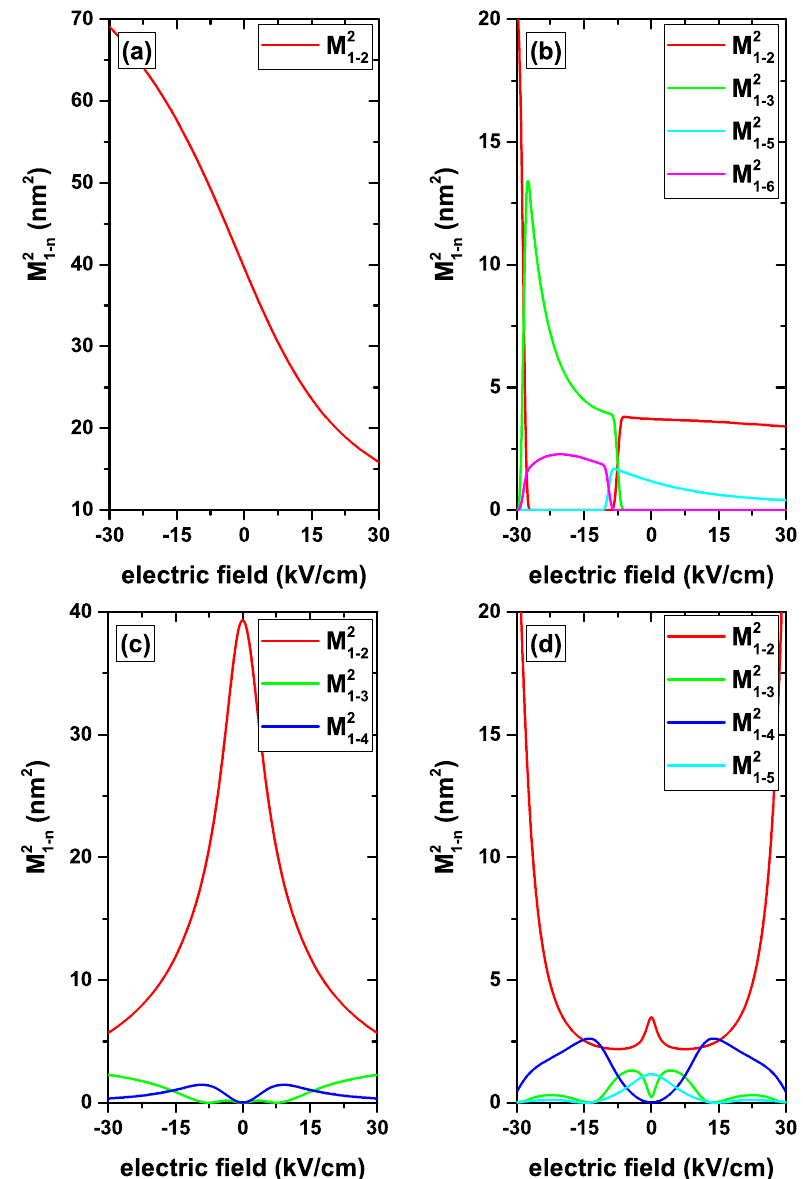
Figure 7. (color online) The squared matrix elements of the transitions from the ground state to the first fourteen excited states with l = 0 ( | 1 (cid:105) → | n (cid:105) , with n = 2,3, . . . ,15) for a confined electron in a CdS/ZnS spherical QD as functions of the central ( a , b ) and z -directed ( c , d ) EF. Results are without ( a , c ) and with ( b , d ) on-center donor impurity, with R 1 = 20nm and R 2 =